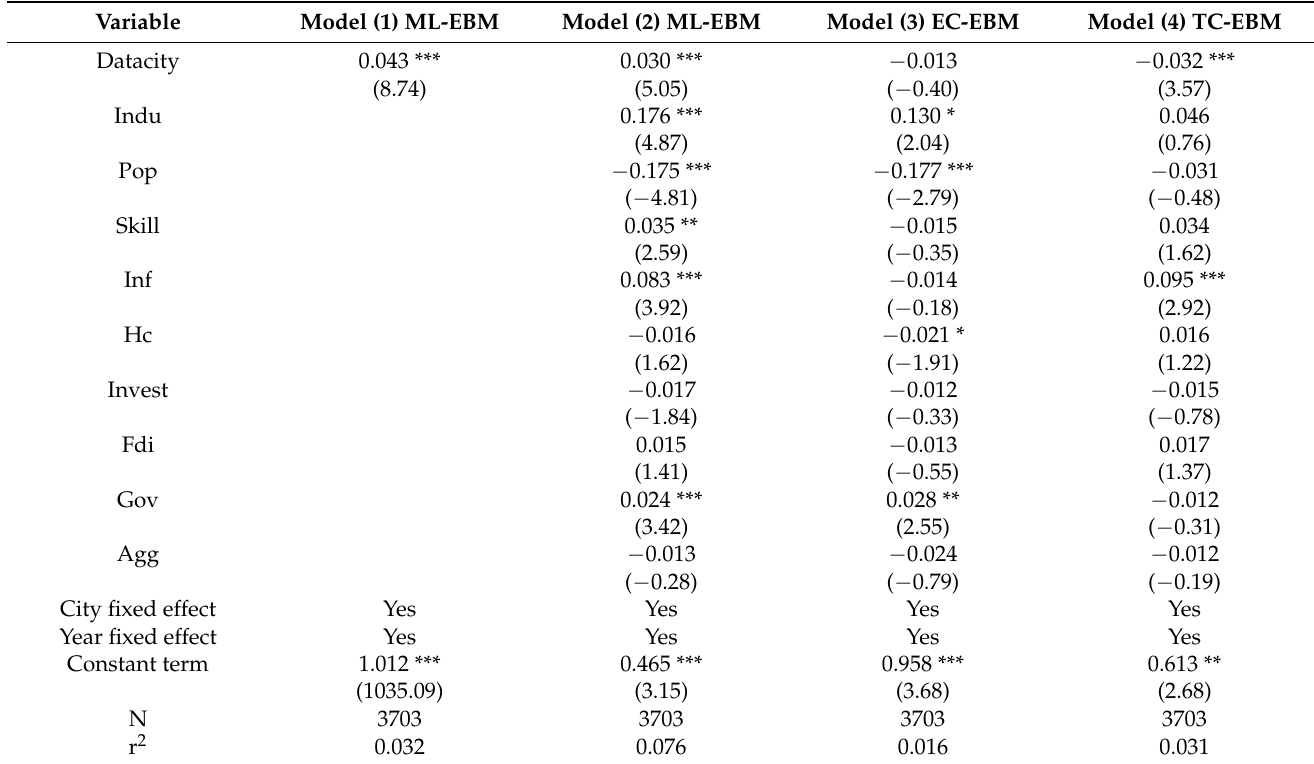
Table 3. Estimation results of the impact of sponge city construction on green total factor